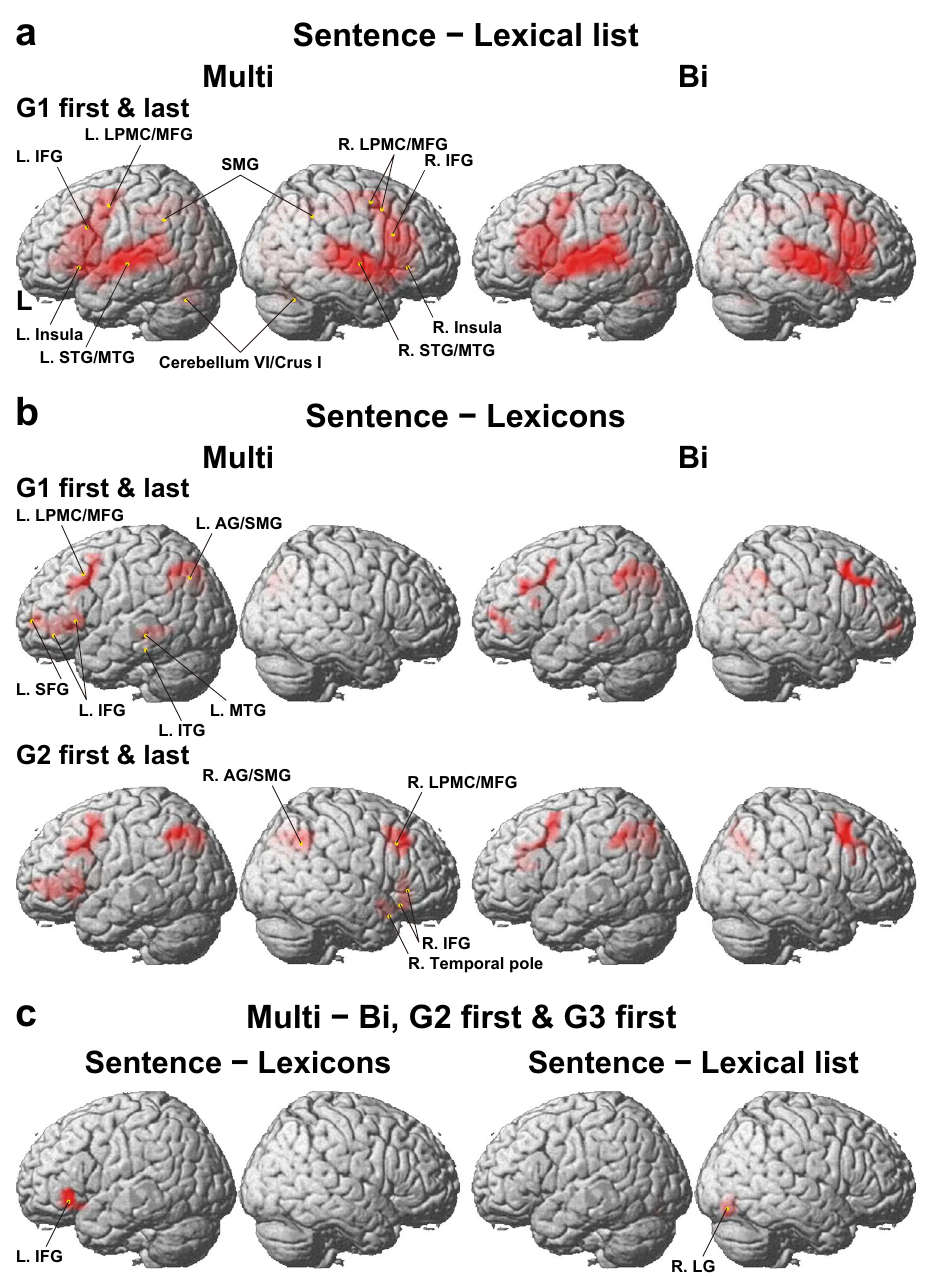
Figure 4. Activation in the lateral regions for the Multi and Bi groups. ( a ) Results of the Sentence–Lexical list contrast in task trials, where "Sentence" and "Lexical list" refer to the the particular events of those presented in Fig. 1. This contrast is shown for the first and last runs under G1 averaged (i.e., G1 first and G1 last , respectively). Both groups showed significant bilateral activations in the frontal and temporal regions (FWE corrected p < 0.05 for the cluster level). ( b ) Results of the more stringent Sentence–Lexicons contrast, where "Sentence" and "Lexicons" refer to the the particular events of those presented in Fig. 1. This contrast is shown for G1 (first and last) and G2 (first and last). For each condition, an exclusive mask of negative activation for the Lexicons were applied (one-sample t -test, uncorrected p < 0.005). ( c ) A direct comparison between the two groups (i.e., Multi– Bi), averaged for the G2 first and G3 first runs. Activations were shown for the Sentence–Lexicons contrast (left panel), and for the Sentence–Lexical list contrast (right panel). Each yellow dot indicates the local maximum of activated regions on the lateral surface (see Table S5). These images were created using SPM12 software (Wellcome Trust Center for Neuroimaging, http:// www. fil. ion. ucl. ac. uk/ spm) and Adobe Illustrator (as